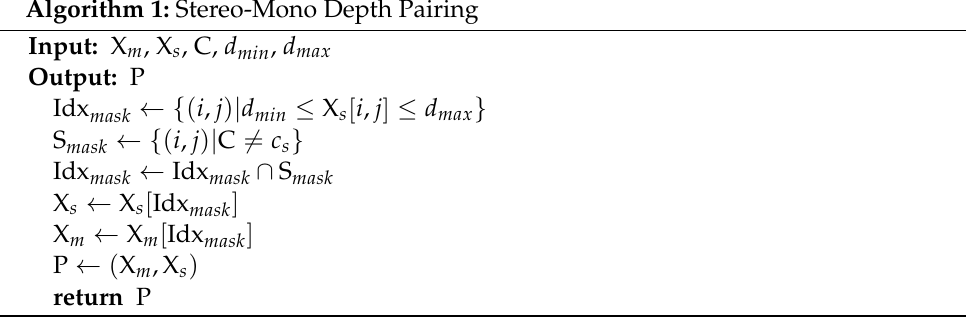
Algorithm 1: Stereo-Mono Depth